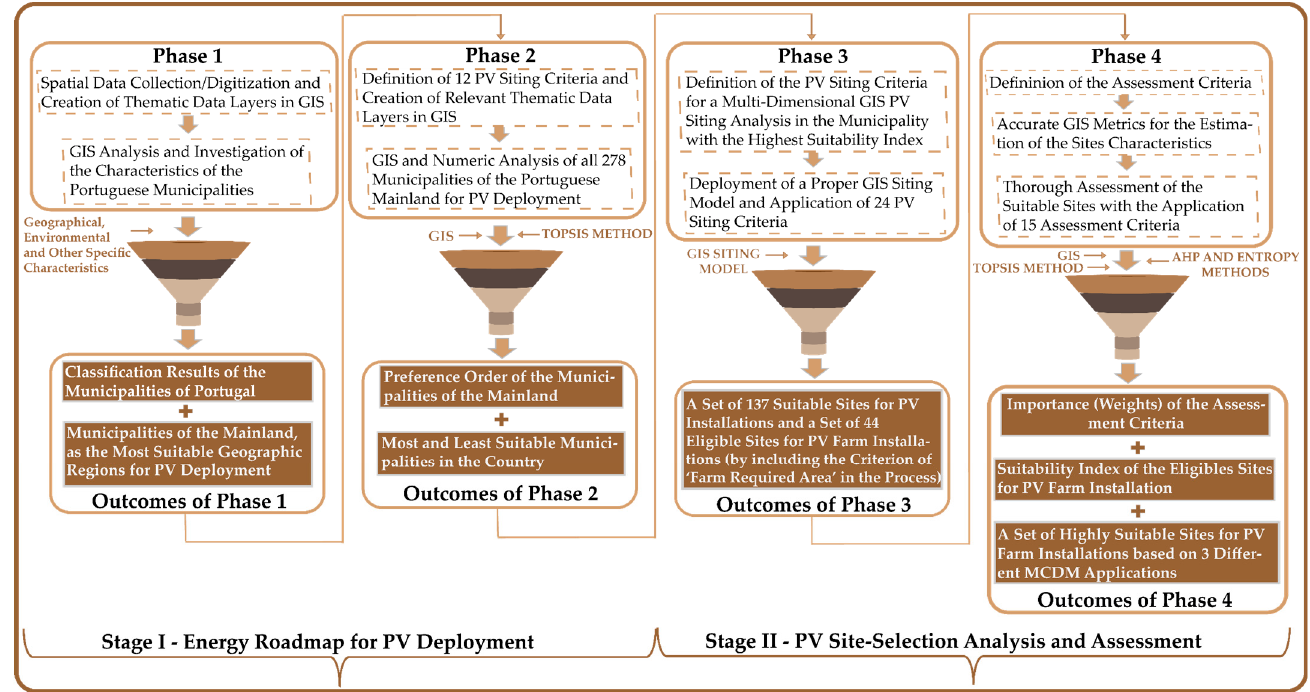
Figure 1. The proposed decision-support framework for sustainable PV site selection in